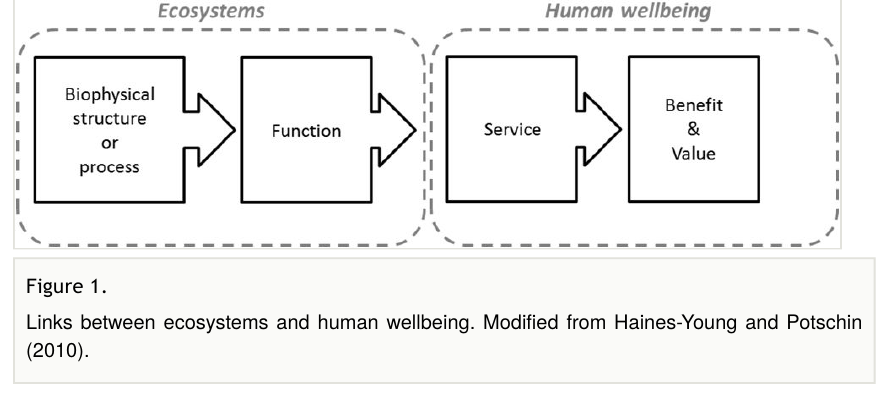
Links between ecosystems and human wellbeing. Modi fi ed from Haines-Young and Potschin